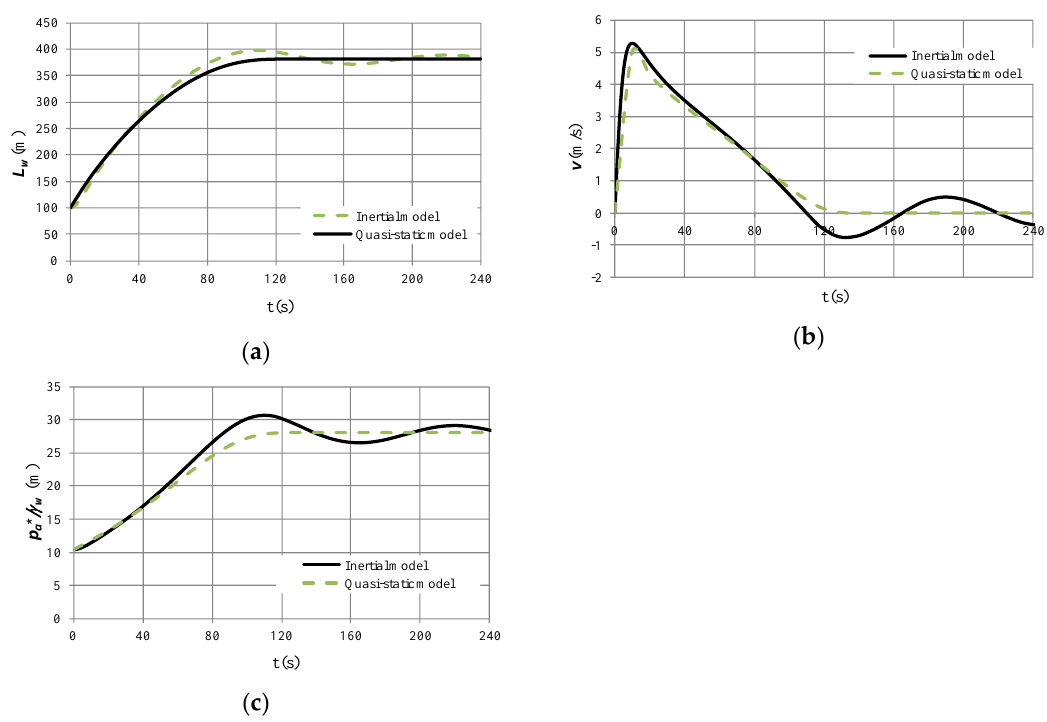
Figure 9. Comparison between internal and quasi-static models for a filling process: ( a ) Water column evolution; ( b ) Behaviour of water velocity; ( c ) Air pocket pressure oscillation.